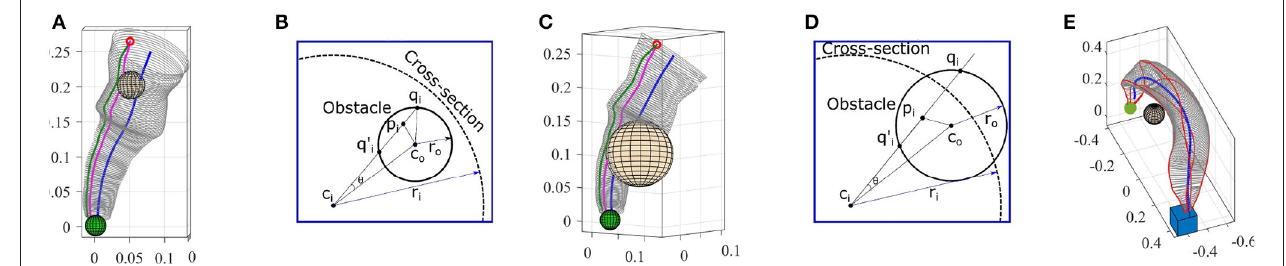
FIGURE 18 | (A,C) Reproductions using fixed-ratio strategy (magenta) collide with obstacles. Adapted reproductions using adaptive-ratio strategy (green) avoid obstacles. (B,D) Planar views for calculating final ratio. (E) Pick-and-place in the presence of an obstacle. GC was deformed using Algorithm 4 to avoid